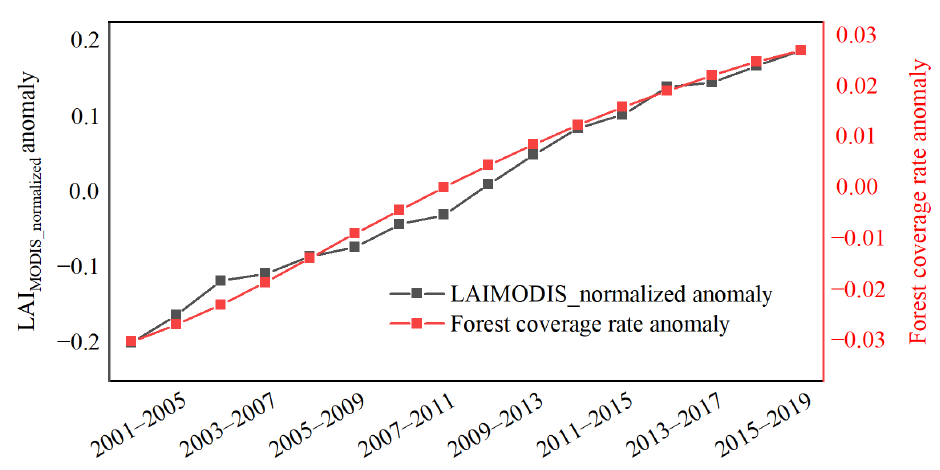
Figure 8. The interannual changes in the LAI MODIS_normalized anomaly and forest coverage rate of the Loess Plateau from 2000 to 2019.